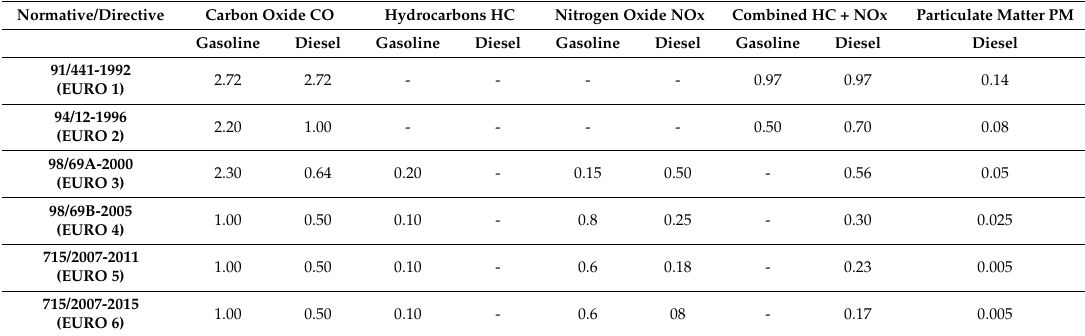
Table 1. EURO Limit Percentages of Gaseous Emissions [g/km]